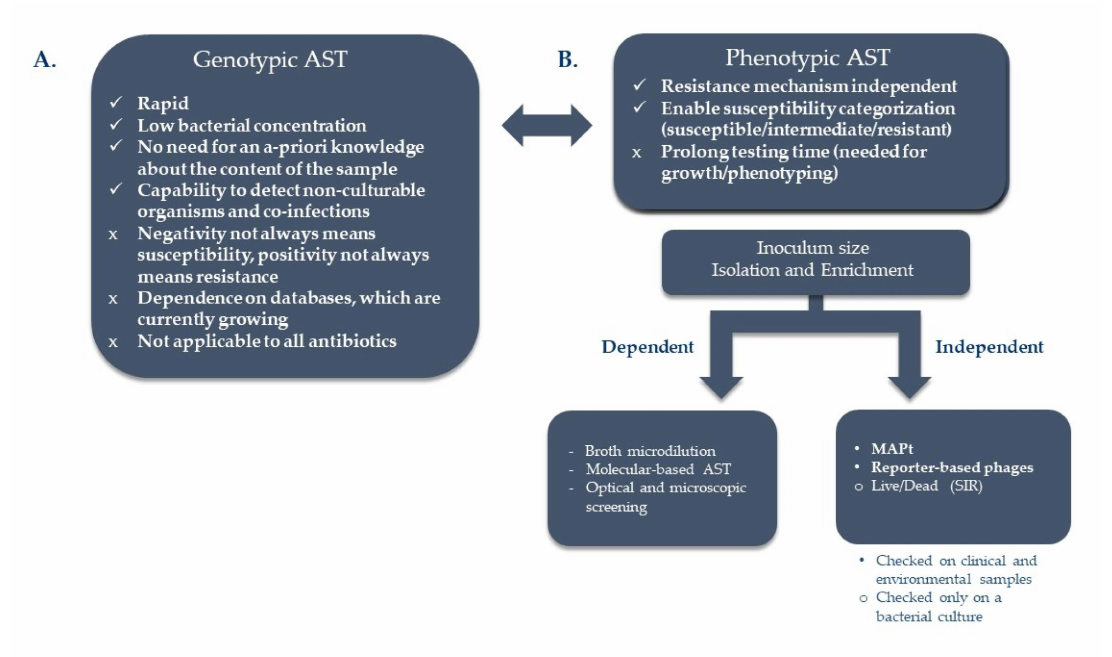
Figure 1. Advantages and disadvantages of the various ASTs. ASTs may be based on genotypic ( A ) or phenotypic measurements ( B ). The main limitations of many of the phenotypic ASTs are the dependence of inoculum size and the time-consuming isolation/enrichment steps. MAPt and reporter-based phage ASTs are promising candidates for ASTs that overcome these